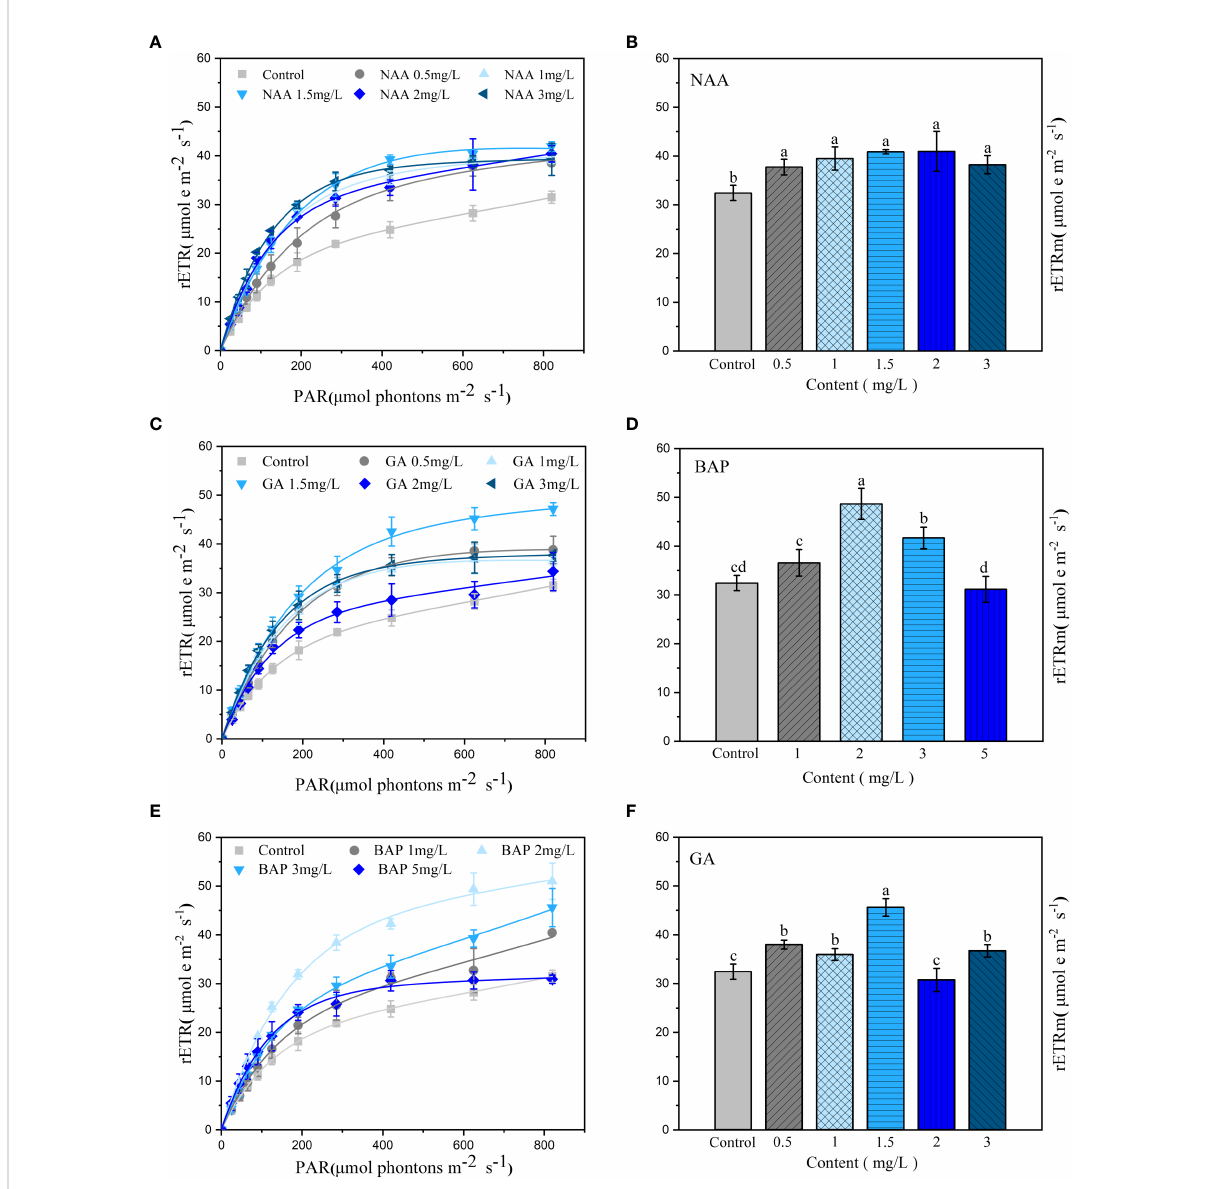
FIGURE 3 Effects of three exogenous hormones on photosynthetic activities in Sargassum fusiforme holdfasts. (A, C, E) : relative electron transfer rate (rETR); (B, D, F) : the maximum relative electron transfer rate (rETRm). Values are the mean ± standard deviation (n = 3). Different letters indicate signi fi cant differences between different culture conditions (p <